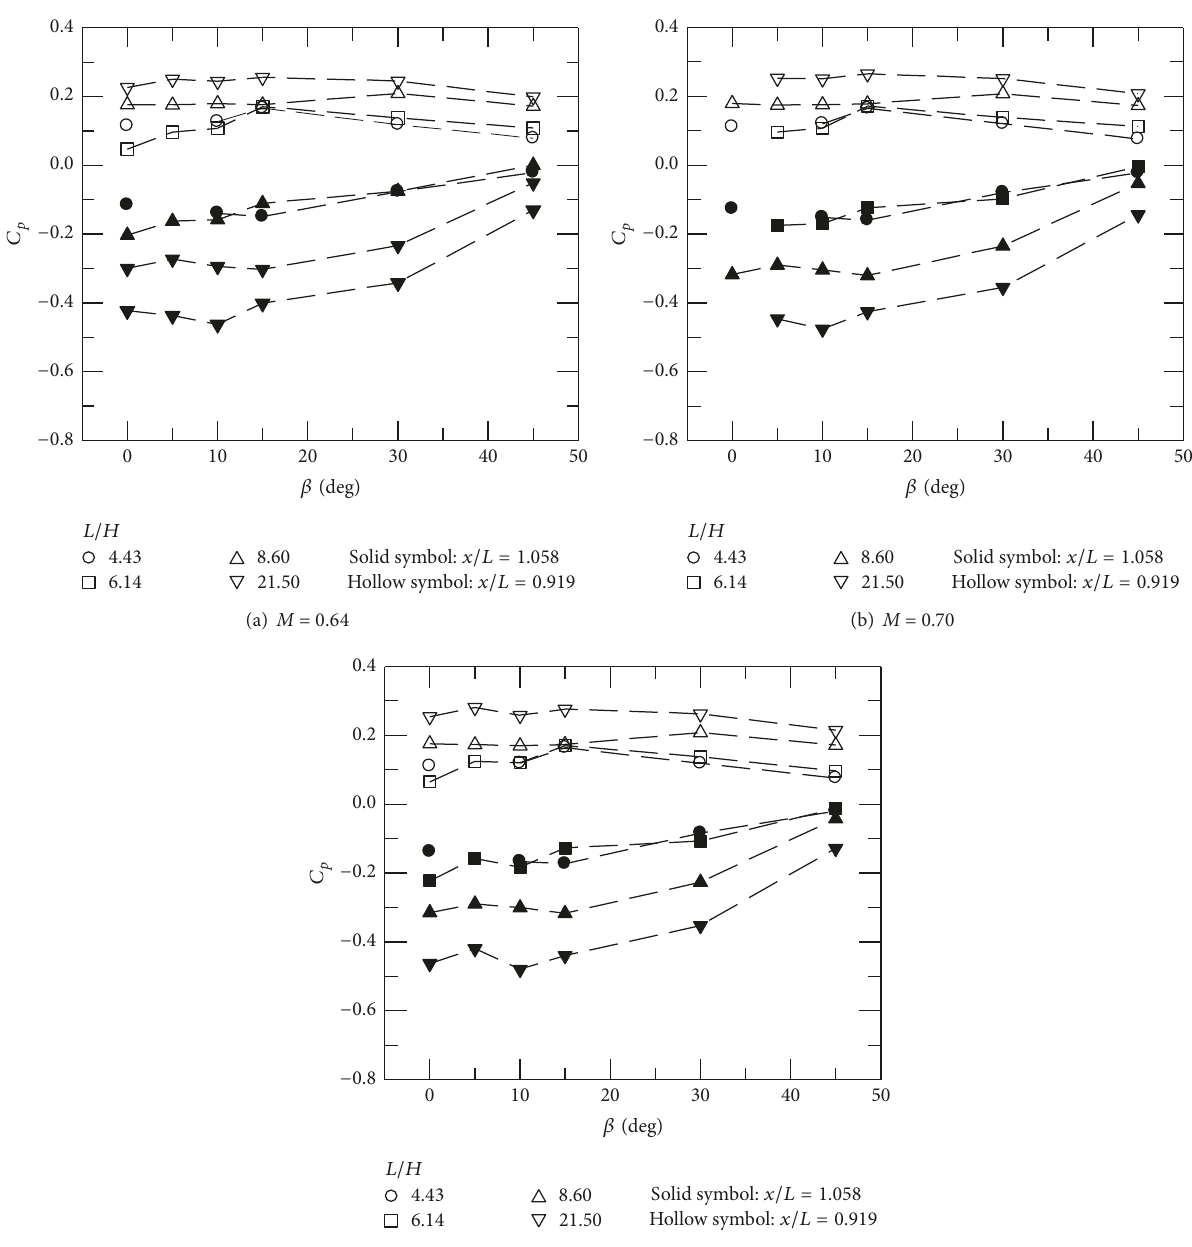
Figure 5: The pressure coefficients near the rear corner ( x/L = 0.919 and 1.058): (a) M = 0.64, (b) M = 0.70, and (c) M = 0.83.